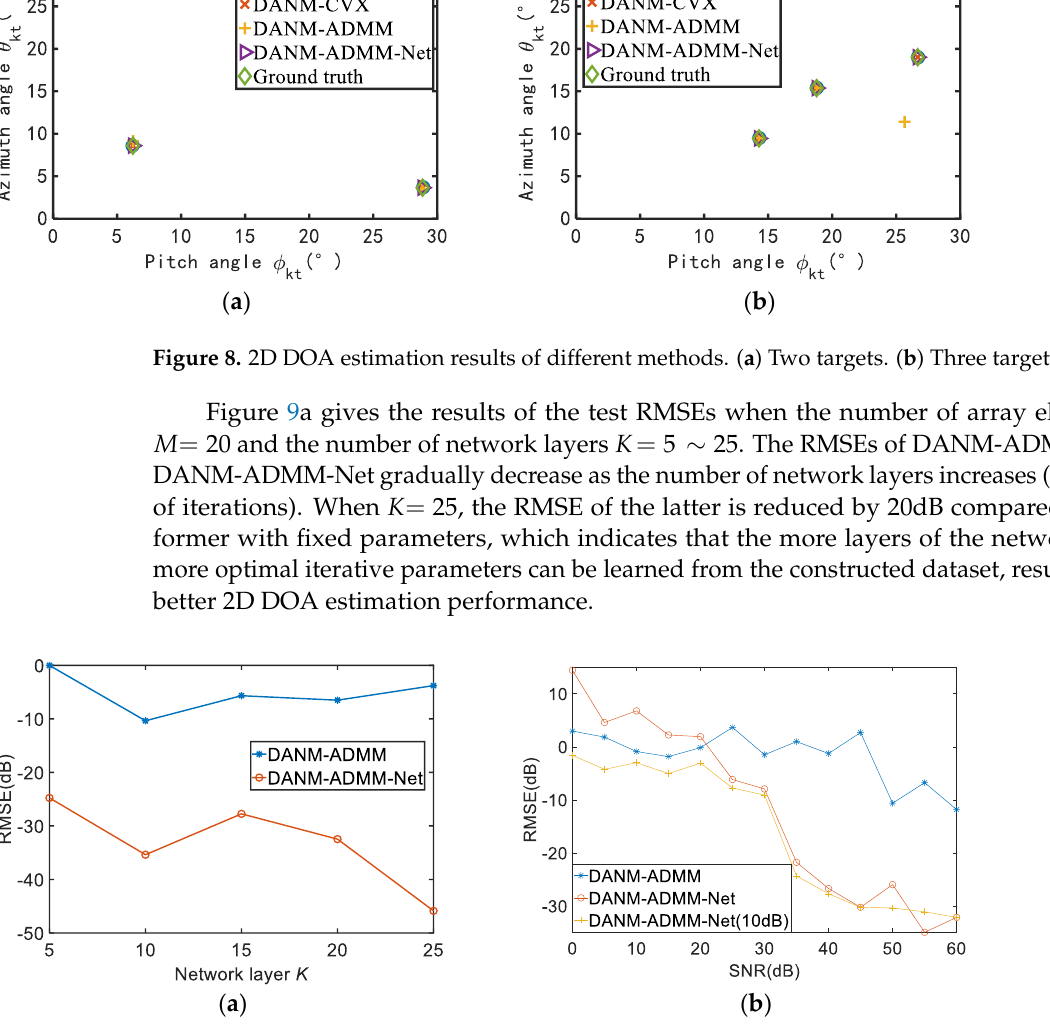
Figure 9. Test RMSEs versus K and SNR ; ( a ) versus network layer K . ( b ) versus SNR .